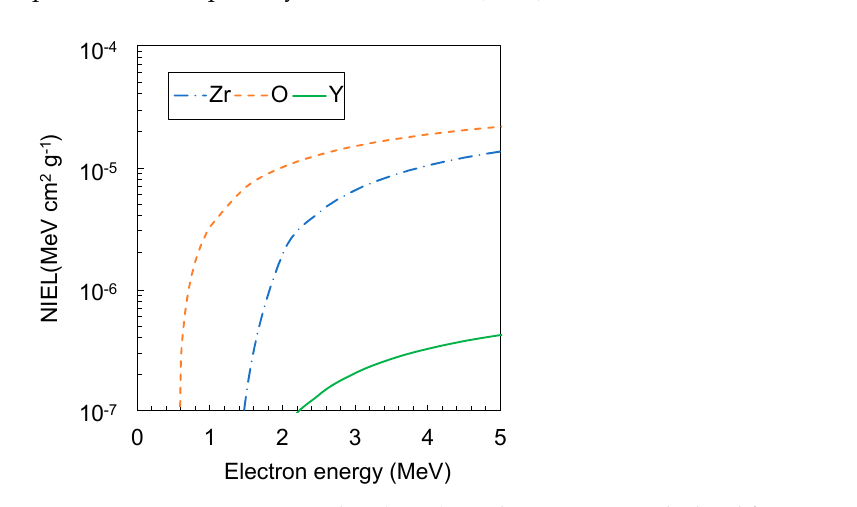
Figure 4. Non-ionizing energy loss (NIEL) vs. electron energy calculated for Zr, Y, and O atoms. The values of E d for Zr, Y, and O are 80, 80, and 120 eV, respectively.